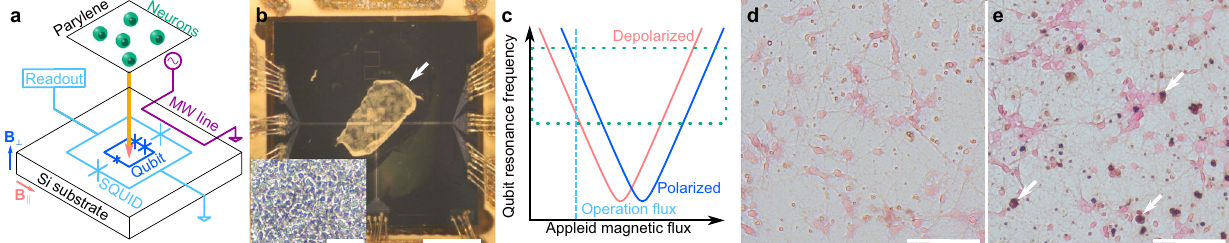
Fig. 1 Experimental setup for magnetometry of cultured neurons using a superconducting fl ux qubit. a Experimental setup. The fl ux qubit (blue) works as a sensitive magnetometer. The quantum state of the qubit is read out by a direct current superconducting quantum interference device (DC SQUID) with a room temperature readout circuit (sky blue). The fl ux qubit is excited by applying a microwave tone to an on-chip microwave (MW) line (purple). Cultured neurons (green) on a parylene-C fi lm are attached to the qubit chip (orange arrow). An in-plane magnetic fi eld B ∥ (pink) is applied to polarize the electron spins in neurons, while a perpendicular magnetic fi eld B ⊥ (blue) is applied to control the operation fl ux of the qubit. b Stereomicroscope image of the qubit chip. The neurons cultured on a parylene-C fi lm are indicated by the white arrow. Scale bar: 1 mm. Inset: Phase-contrast image of neurons on a parylene-C fi lm. Scale bar: 100 μ m. c The principle of magnetometry using a fl ux qubit. The qubit spectrum with (without) magnetic fl ux generated by the electron spins in neurons is shown by the blue (pink) curve. The magnetometry is performed by monitoring the change in the qubit resonance frequency at a fi xed operation fl ux (sky blue). The green dotted rectangle corresponds to measured regions in Fig. 2a. It is worth mentioning that the direction of the shift depends on experimental details (e.g., direction of the in-plane fi eld) and can be reverse. d , e Bright fi eld image of neurons cultured in medium containing d 0.2 μ M (control) and e 50 μ M of Fe 3 + stained by nuclear fast red (cell soma; pink) and Prussian Blue with 3,3 ’ -diaminobenzidine (Fe 3 + ; dark brown). The white arrows in e indicate examples of the neurons with high Fe 3 + concentration. Scale bars: 100 μ